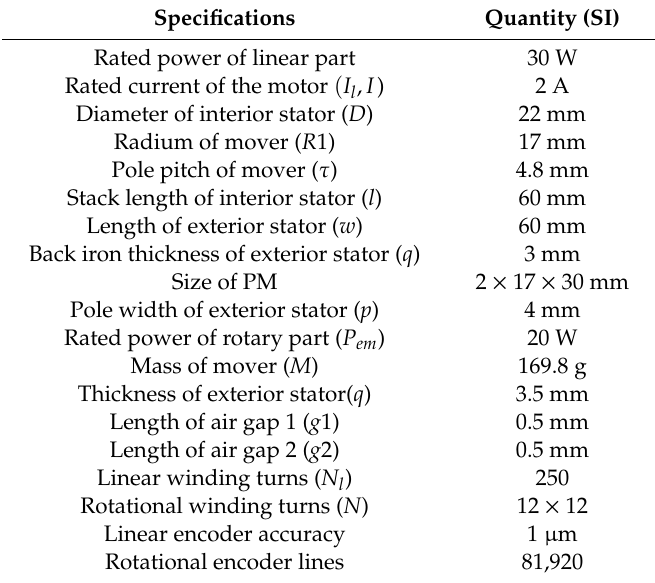
Figure 3. The structure of the rotary part ( a ) and its section view ( b ). Table 1. The main specifications of the motor.